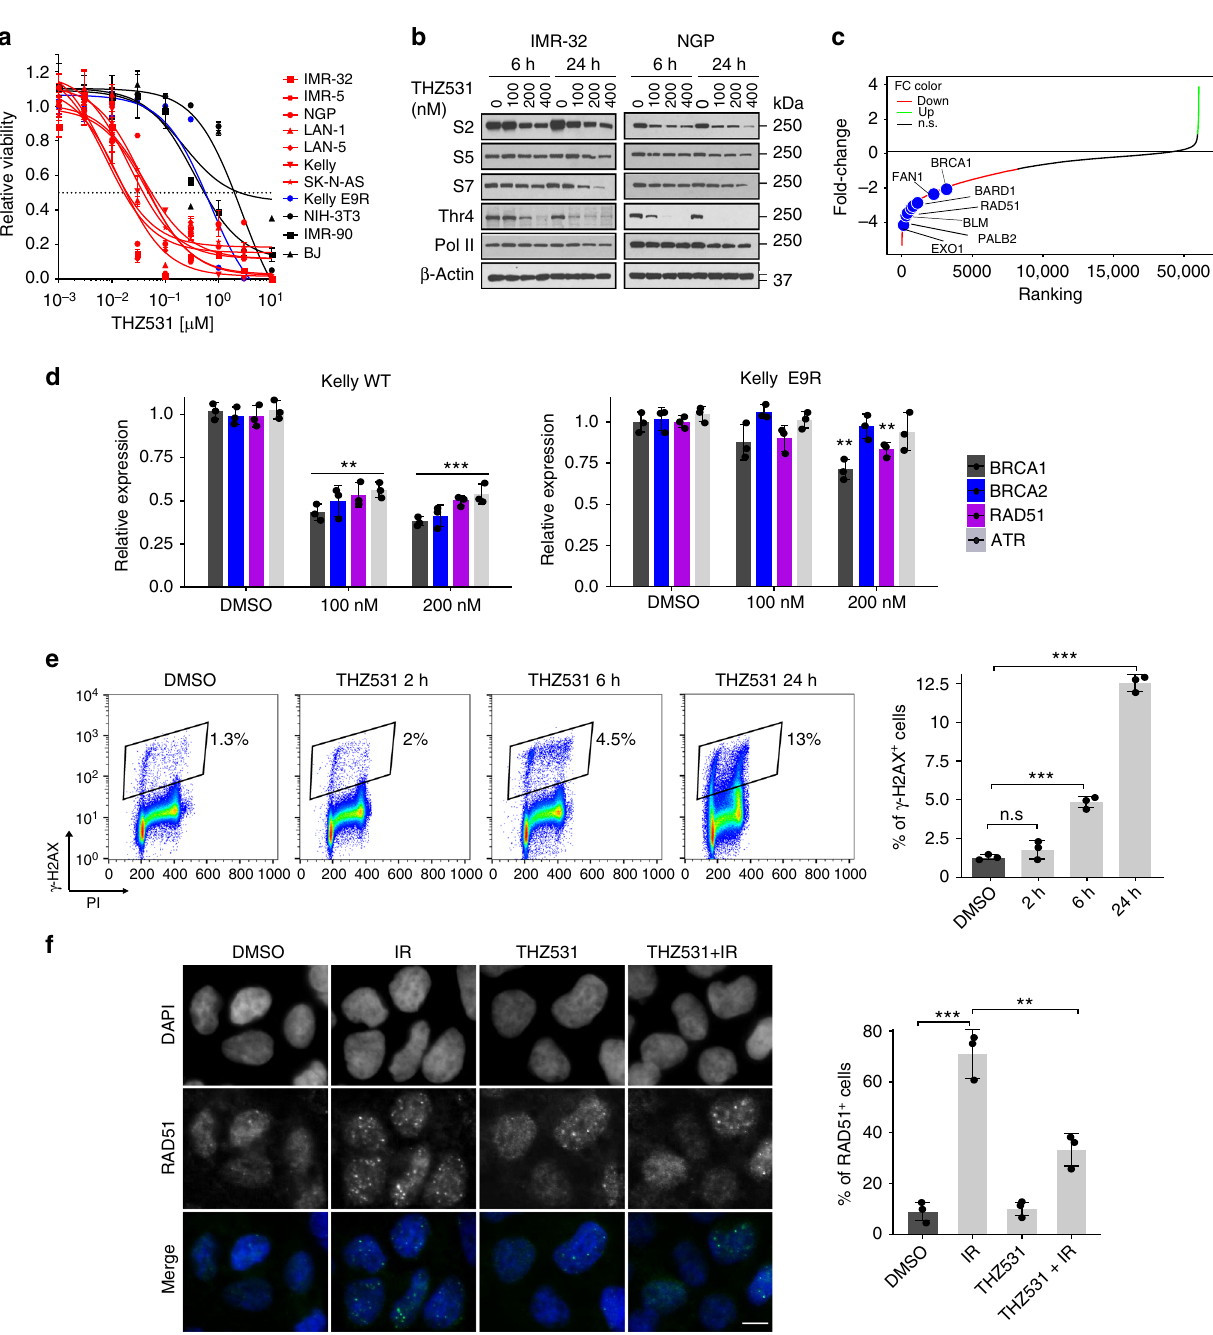
Fig. 1 CDK12/13 inhibition results in selective cytotoxicity in NB cells and affects transcription elongation. a Dose-response curves for human NB cells treated with increasing concentrations of THZ531 for 72 h. Kelly E9R cells, which express a homozygous mutation at the Cys1039 THZ531-binding site in CDK12 20 (see Methods) were also included. Fibroblast cells (NIH-3T3, IMR-90, BJ) were used as controls. Cytotoxicity is reported as percent cell viability relative to DMSO-treated cells. Data represent mean ± SD; n = 3. b Western blot analysis of Pol II phosphorylation in NB cells treated with THZ531 or DMSO at the indicated concentrations for the indicated times. c Waterfall plot of fold-change in gene expression in IMR-32 NB cells treated with THZ531, 400 nM for 6 h; selected DDR genes are highlighted. d qRT-PCR analysis of the indicated DDR gene expression in Kelly WT (left) cells and Kelly E9R (right), treated with THZ531 or DMSO at the indicated concentrations for 6 h. Data are normalized to GAPDH and compared to the DMSO control. e Flow cytometry analysis of γ -H2AX staining in Kelly NB cells treated with 400 nM THZ531 for the indicated time points (left). Gating was performed as shown in the left panel. Numbers indicate the percentages of living cells that stained positive for γ -H2AX. Quanti fi cation of staining (right). f Immuno fl uorescence staining of RAD51 focus formation in Kelly NB cells treated with THZ531 (400 nM) or DMSO for 24 h prior to exposure to gamma radiation (IR, 8 Gy). Nuclei are stained with DAPI (scale bar, 10 µ M). Quanti fi cation of staining (right) of RAD51 + cells (>5 RAD51 foci per cell). Throughout the fi gure, error bars indicate mean values ± SD of three independent experiments, **p < 0.01 , ***p < 0.001; two-tailed Student ’ s t